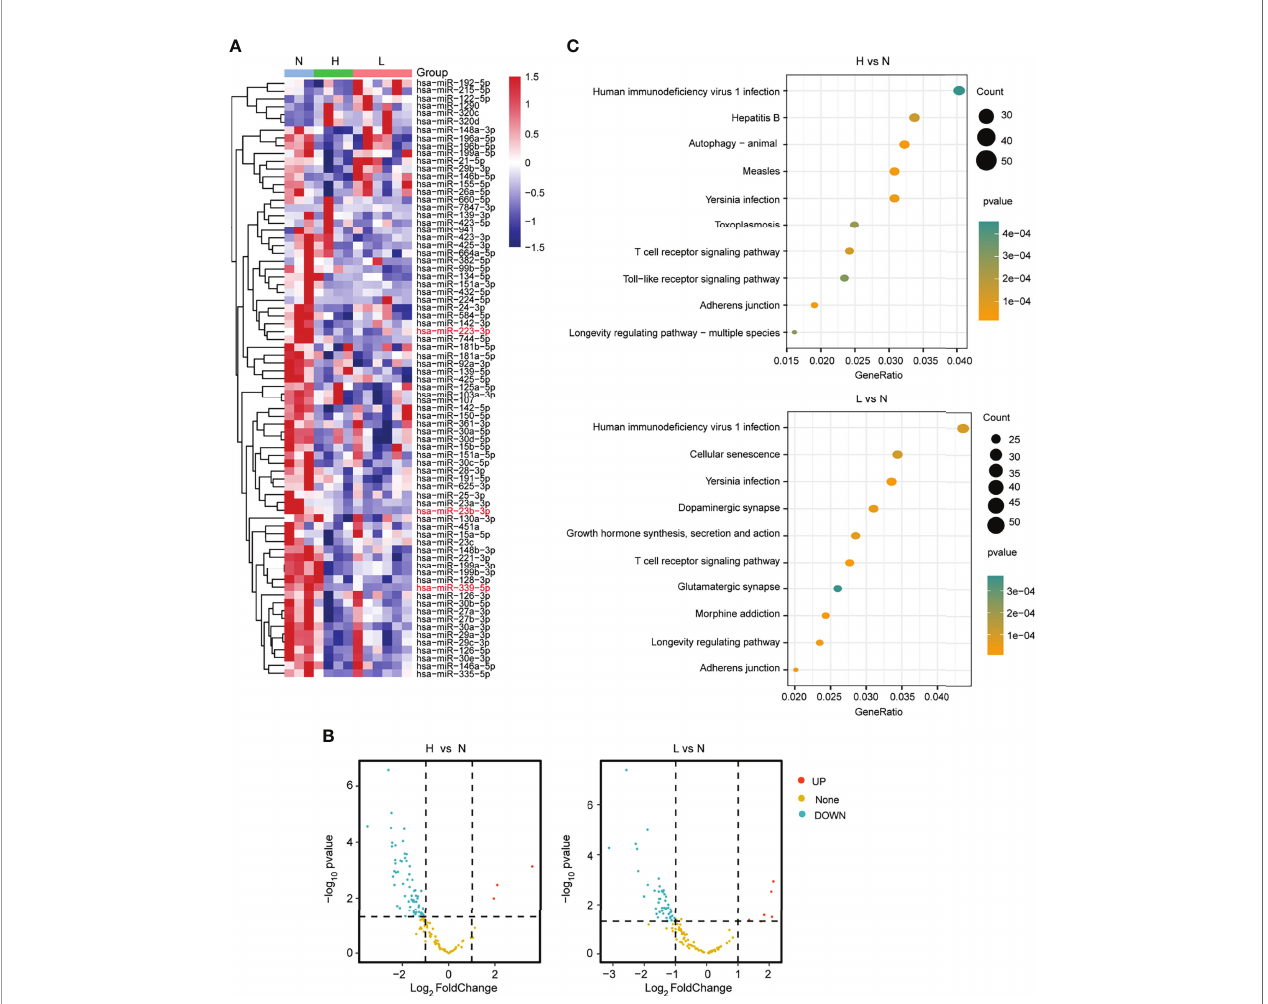
FIGURE 2 | Differential expression analysis of miRNAs from plasma. (A) The heatmap showed the differentially expressed miRNAs in the L, H, and N group samples. (B) The volcano plot presented the differentially or non-differentially expressed miRNAs between the H vs. N and L vs. N comparison groups. (C) The KEGG pathway analysis for the differentially expressed miRNAs in the above two comparison